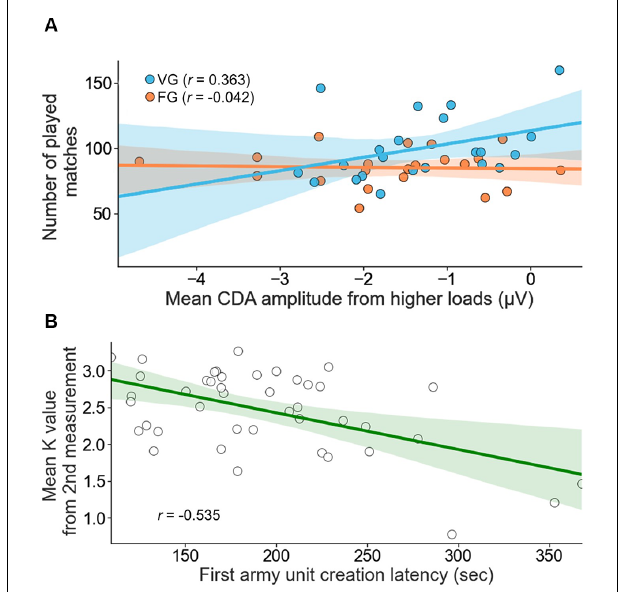
FIGURE 5 | In-game behaviors relationship to psychophysiological and behavioral variables. (A) Initial (from the 1st measurement point) contralateral delay activity (CDA) averaged across loads 4 and 5 predicts the overall number of played matches in the Variable Environment Group (VEG). Observed effect turned out to be insignificant in the Fixed Environment Group (FEG) only. (B) The averaged across training latency of first army unit creation predicts participants’ mean K value obtained in post-training measurement. The effect was significant in both groups. [ F (1, 59) = 0.087, p = 0.769, η 2 = 0.002], Group [ F (2, 59) = 2.212, p = 0.118, η 2 = 0.02], Load ∗ Session interaction [ F (3, 57) = 1.336, p = 0.272, η 2 = 0.066], Load ∗ Group interaction [ F (6, 116) =